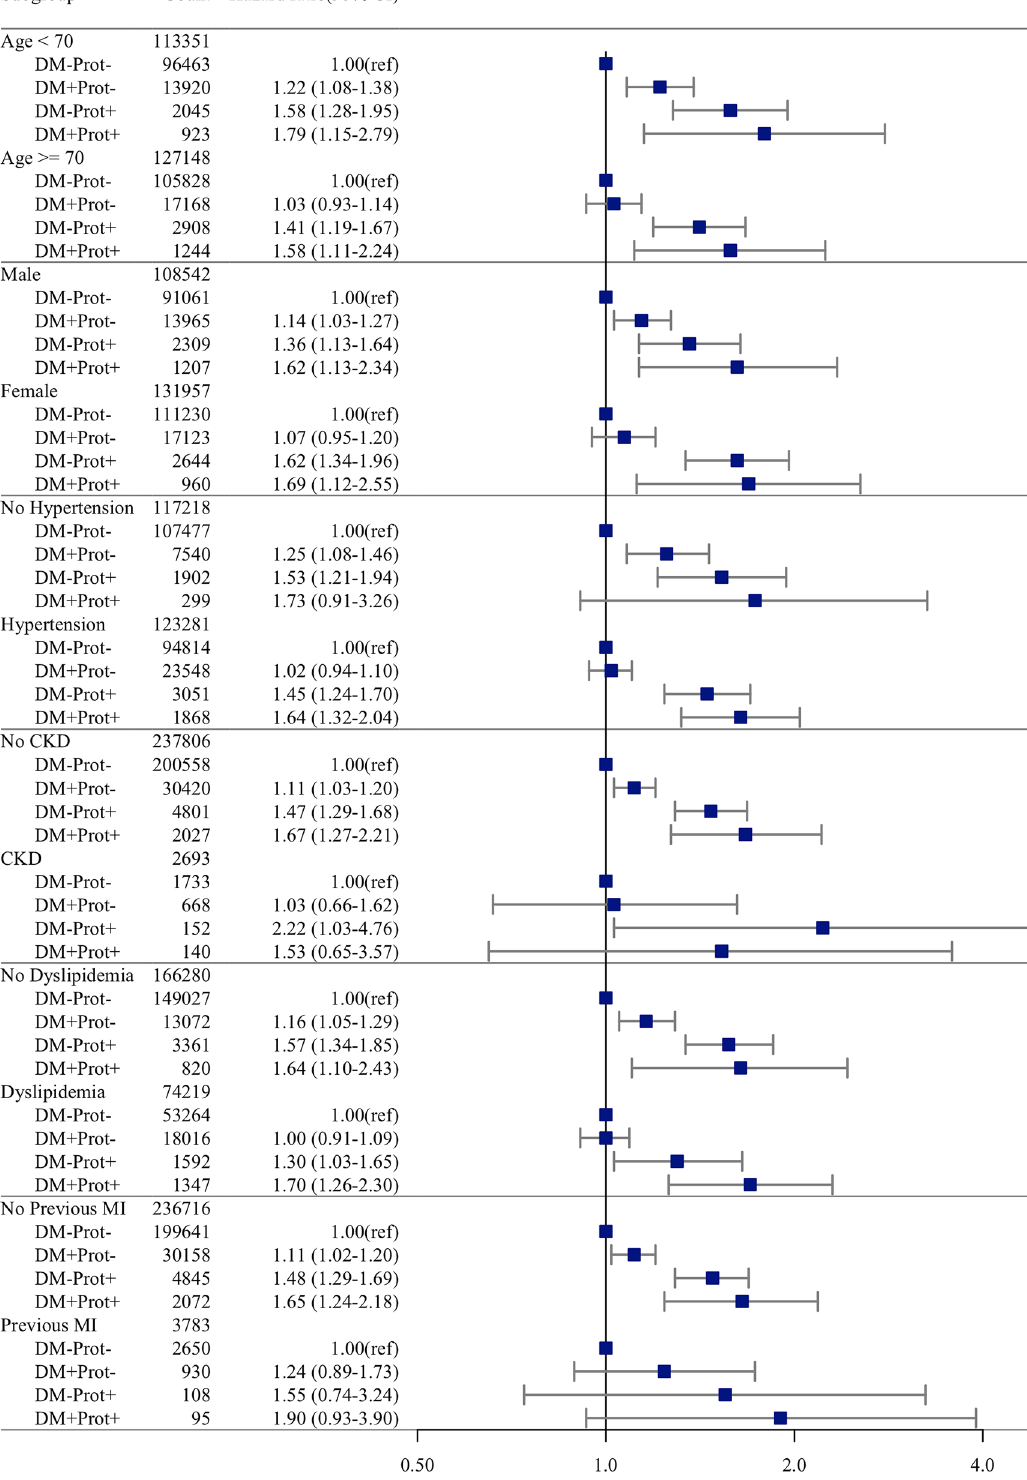
Figure 2. Hazard ratio for incident atrial fibrillation in different subgroups in overall population. Boxes indicate the hazard ratio, limit lines indicate the 95% confidence interval, and the vertical line (at hazard ratio 1) indicates no difference in the hazard ratios between atrial fibrillation and no atrial